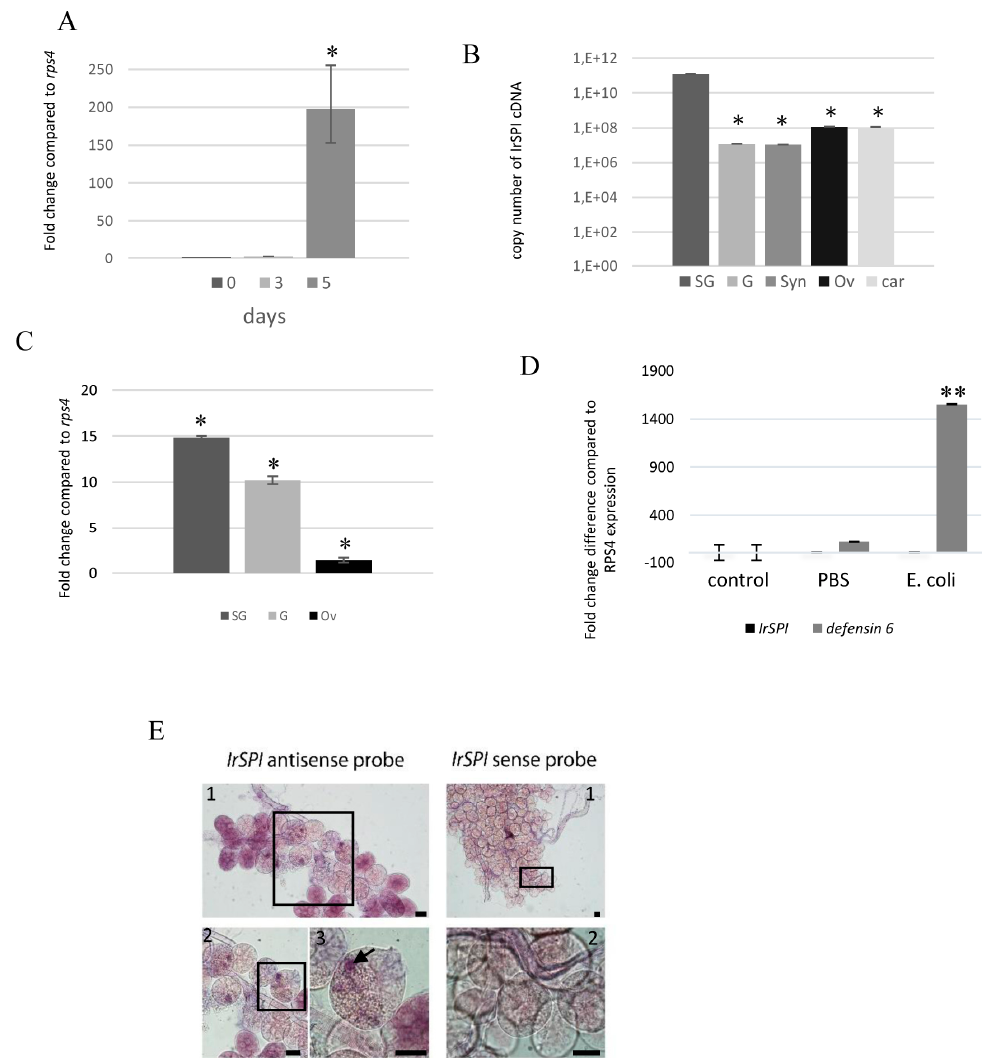
Figure 3. IrSPI transcript profiling and localization. ( A ) Relative IrSPI expression in pathogen-free nymphs fed on rabbits revealing the delayed gene expression on day 5. At each feeding time point (Days 0, 3, and 5), 20 pathogen-free nymphs were used, and IrSPI expression was assessed by quantitative RT-PCR relative to the rps4 gene. ( B ) Relative IrSPI expression in several organs of wild female ticks pre-fed for five days on the rabbit. Pools of salivary glands (SG), gut (G), synganglion (Syn), ovaries (Ov), and the remaining body, i.e., the carcasses (car) from 17 females were used for each condition, and IrSPI expression was assessed by quantitative RT-PCR according to the copy number of IrSPI plasmid clones. ( C ) Relative expression of IrSPI in pools of 13 salivary glands (SG), 14 guts (G), and 16 ovaries (Ov) from B. henselae -infected females pre-fed for four days assessed by quantitative RT-PCR, compared with uninfected samples, and expressed as a fold change with respect to the rps4 gene. ( D ) Relative IrSPI and defensin6 expression after E. coli injection. Three pathogen-free females per group either received no injection (Control), 250 nl of PBS (PBS), or 250 nl of 10 7 bacterial CFU ( E. coli ). After 24 h incubation, quantitative RT-PCR was used to assess the mean expression of IrSPI and defensin 6 normalized to rps4 . ( E ) In situ hybridization of IrSPI mRNA in salivary glands of pathogen-free females pre-fed for eight days on the membrane. A specific IrSPI anti-sense probe was incubated on salivary glands and visualized through the addition of NBT/BCIP. Arrows indicate the presence of IrSPI transcripts in cells containing secretory vesicles in type II acini. An IrSPI sense probe was used as a negative control. Fields 1 to 3 are successive zooms. The scale bars are 60 µm. One asterisk (*) indicate significant ( p < 0.05) and two asterisks (**) highly significant ( p < 0.01) differences as determined by Student’s t-test.